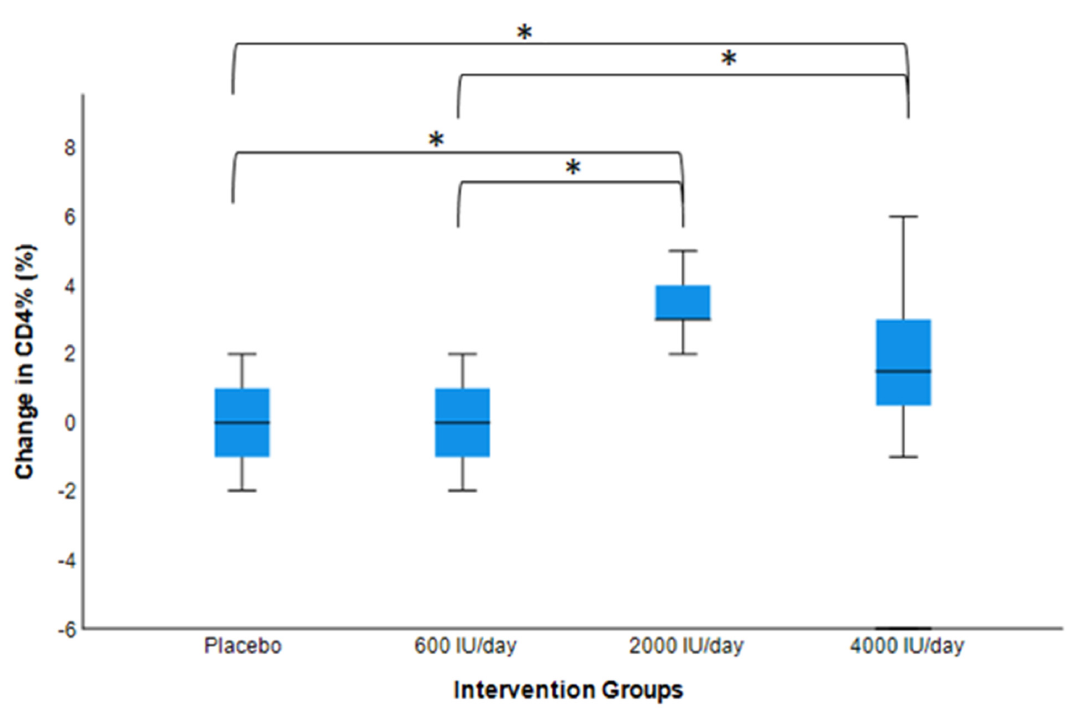
Figure 2. Changes in CD4 + % (post- vs. pre-intervention values) by dose–response. Model adjusted for baseline value, age, sex, BMI, and seasons of the year (n = 50). *The mean changes for the 4000 IU/day group and 2000 IU/day group were significantly higher than those for the placebo and 600 IU/day group ( p < 0.05). No significant differences however were found between the 2000 and 4000 IU/day groups. We also examined the relationship between changes in CD% and changes in serum 25(OH)D, and showed that the highest Delta 25(OH)D quartile group had the highest change in CD3% and CD4% ( Figure 3; Figure 4).